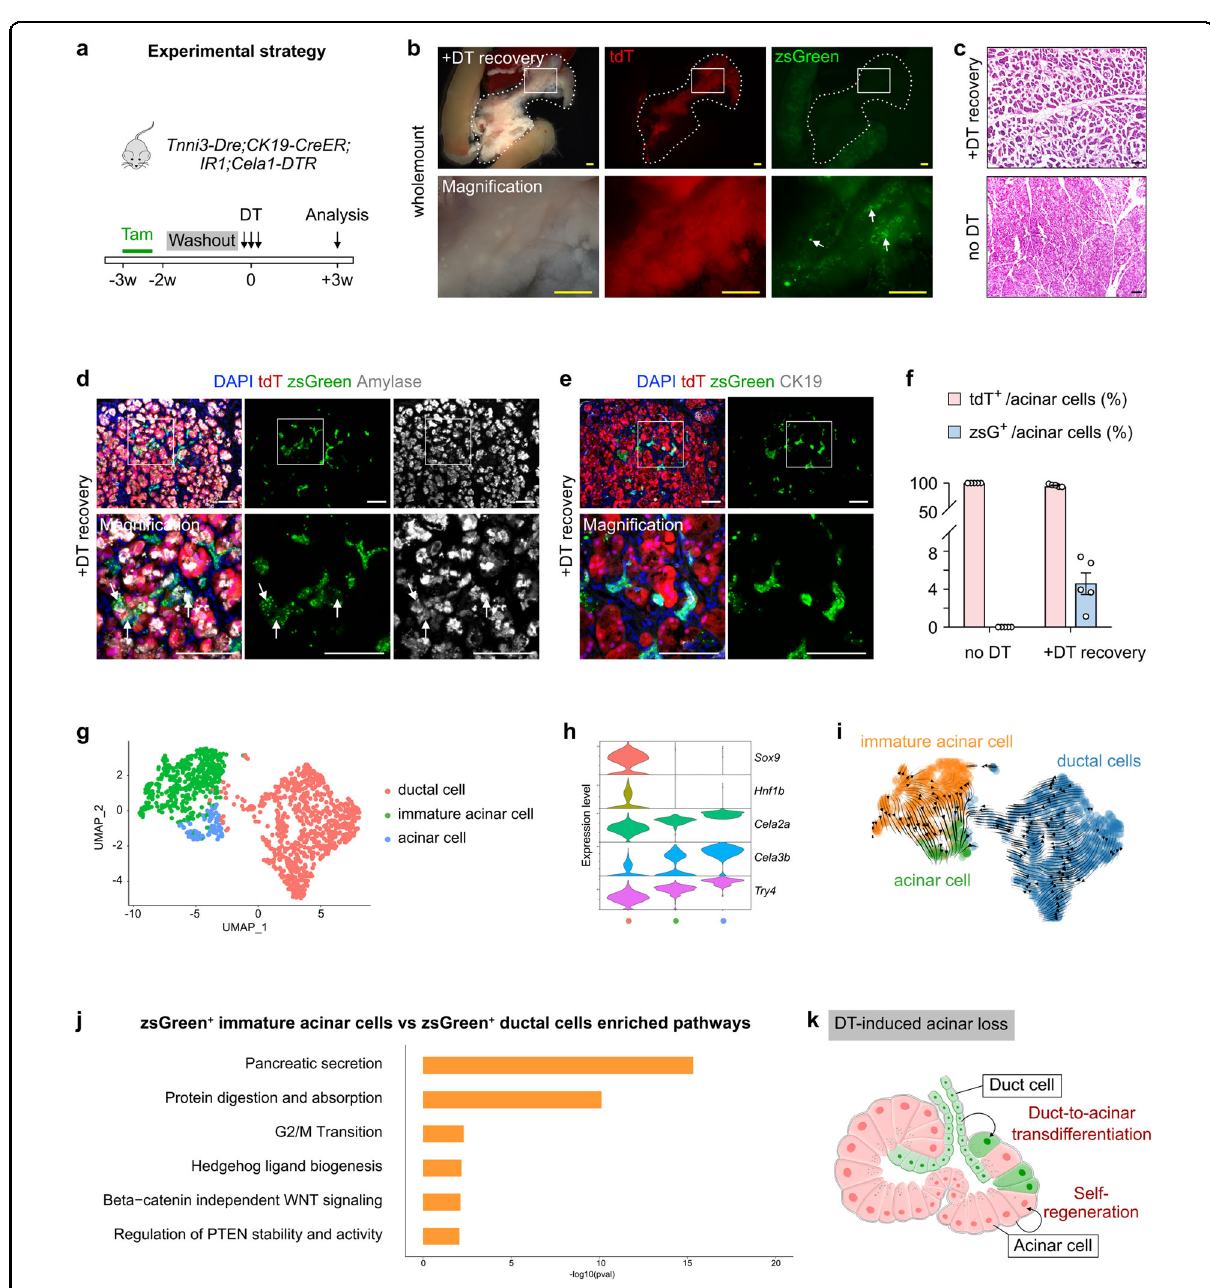
Fig. 7 Ductal-to-acinar transdifferentiation occurs after DT-induced acinar cell loss. a Schematic diagram illustrating the experimental timeline for cell labeling with Tam, washout, injury by DT treatment and analysis. b Whole-mount bright- fi eld and fl uorescent images showing zsGreen and tdT expression in the pancreas from Tnni3-Dre;CK19-CreER;IR1;Cela1-DTR mice 3 weeks after DT treatment. c H&E staining on pancreatic sections from the indicated mice. d , e Immunostaining for tdT, zsGreen and Amylase ( d ), or CK19 ( e ) on pancreatic sections collected from the indicated mice. White arrows, zsGreen + acinar cells. f Quanti fi cation of the percentage of acinar cells expressing zsGreen or tdT from the indicated mice. Data are means ± SEM; no DT group, n = 5; + DT recovery group, n = 5. g UMAP visualization of the zsGreen + epithelial cell clusters. h UMAP plots showing expression of indicated genes. i UMAP embedding of RNA velocity of zsGreen + pancreatic epithelial cells from Tnni3-Dre;CK19-CreER;IR1;Cela1-DTR mice after recovery. j Selected GO terms enriched in zsGreen + immature acinar cells compared with zsGreen + ductal cells. k Diagram illustrating that a subset of new acinar cells is derived from zsGreen + ductal cells after DT-induced acinar cell loss. Scale bars, yellow, 1 mm; white and black,100 μ m. Each image is representative of 5 individual